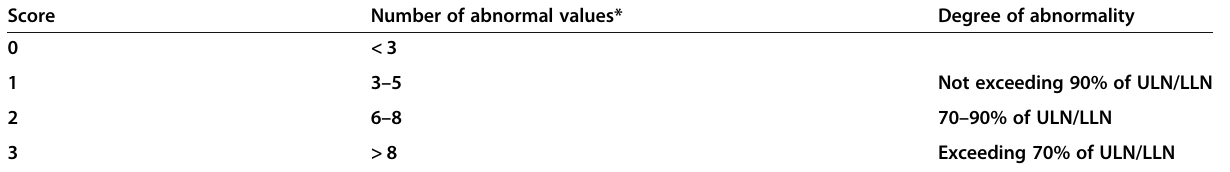
Table 1 Neuropathy electrodiagnostic severity score (NESS)